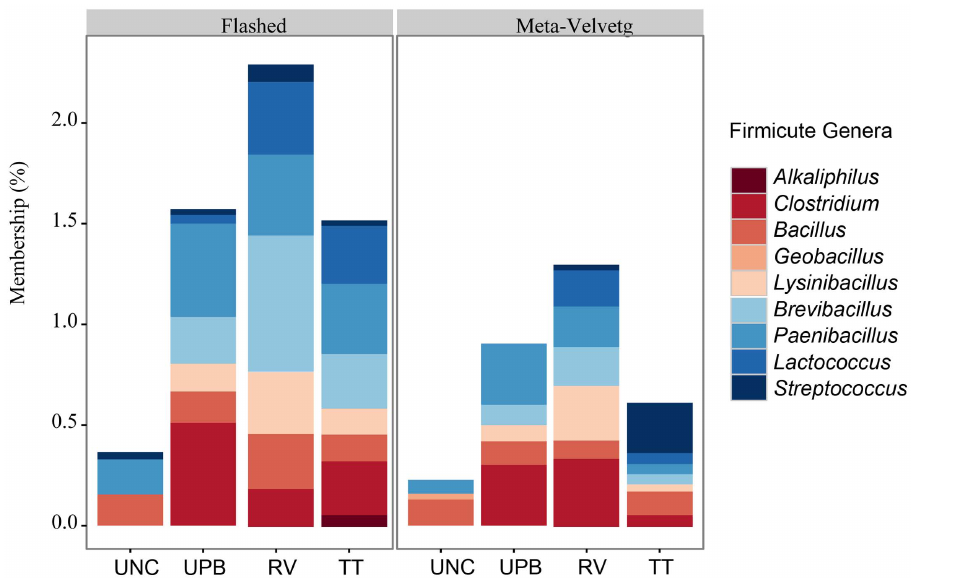
Figure 5. Taxonomic classification of Firmicute genera associated with metagenomic and shotgun sequenced enrichments using FLASHed and Meta Velvetg assembly and the lowest common ancestor taxonomic rank among the best hits (maximum e-value